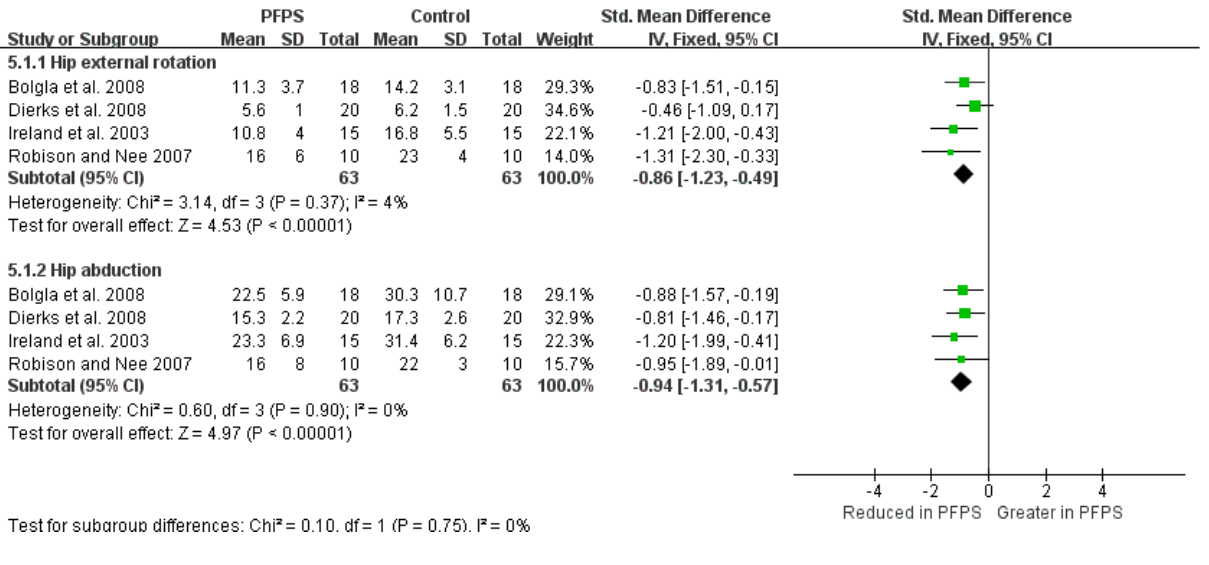
Figure 8. Hip strength in isometric strength testing [14,21,23,24].